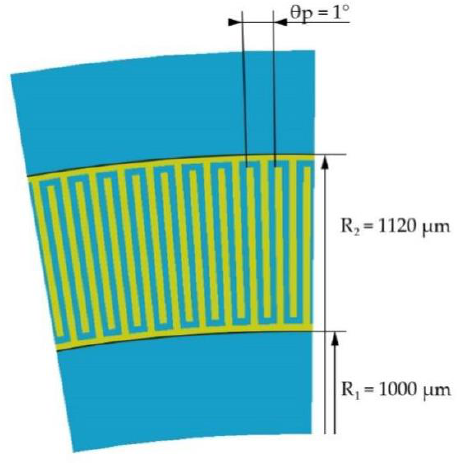
Figure 6. Inter-digital transducer geometry.